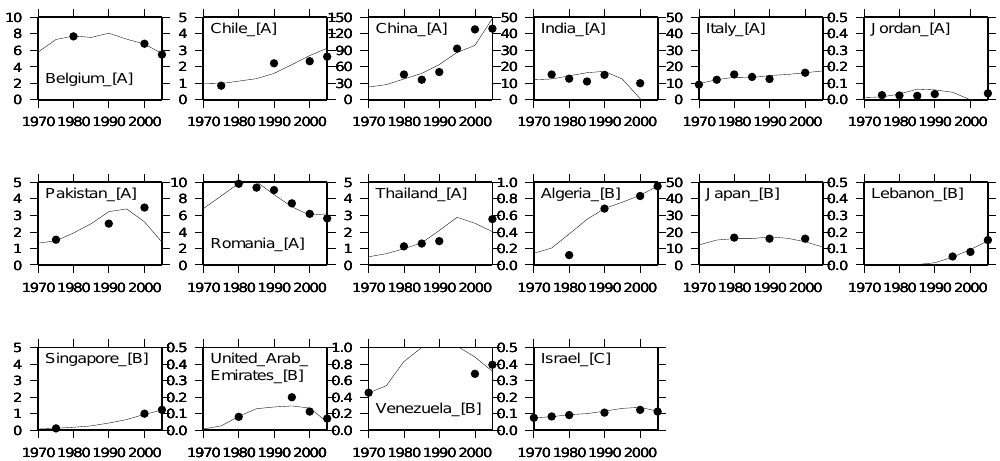
Fig. 5. Historical records of national industrial water withdrawal (plot) and estimations with Eq. (4) (line) (km 3 yr − 1 )